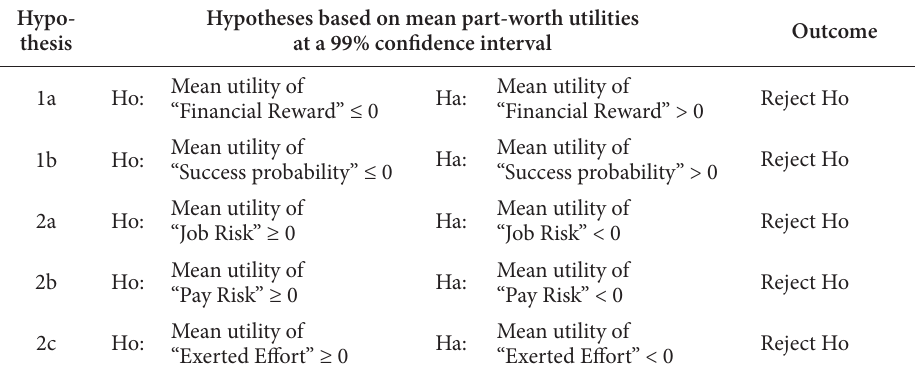
Table 3. Hypothesis 1 and 2 outcomes